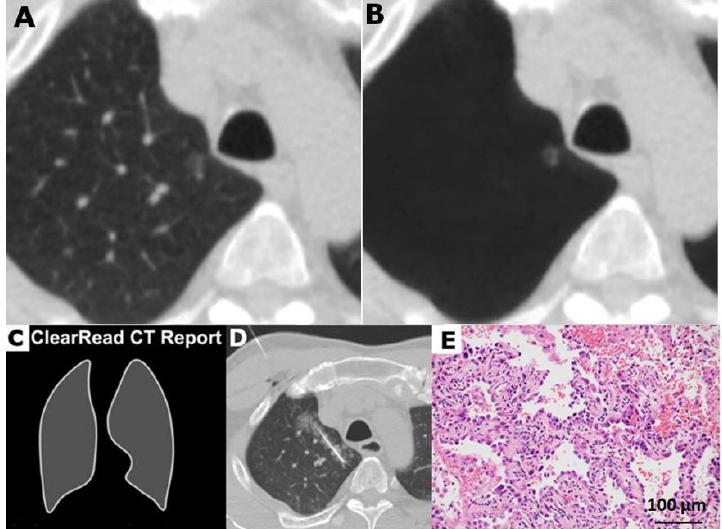
Figure 4. A 58-year-old male with minimally invasive adenocarcinoma in right upper lobe (RUL). ( A ) Low-dose computed tomogram and ( B ) its vessel-suppressed image showed a 6.2 mm ground-glass nodule in RUL. The nodule is relatively ill defined and suspiciously lobulated. ( C ) The vessel-suppressed and computer-aided detection artificial intelligence analyzer determined it as a non-actionable nodule and did not prompt an analysis summary. ( D ) Computed tomography guided needle localization was performed. ( E ) Microphotograph of the specimen showed minimally invasive adenocarcinoma (hematoxylin and eosin stain, 200).